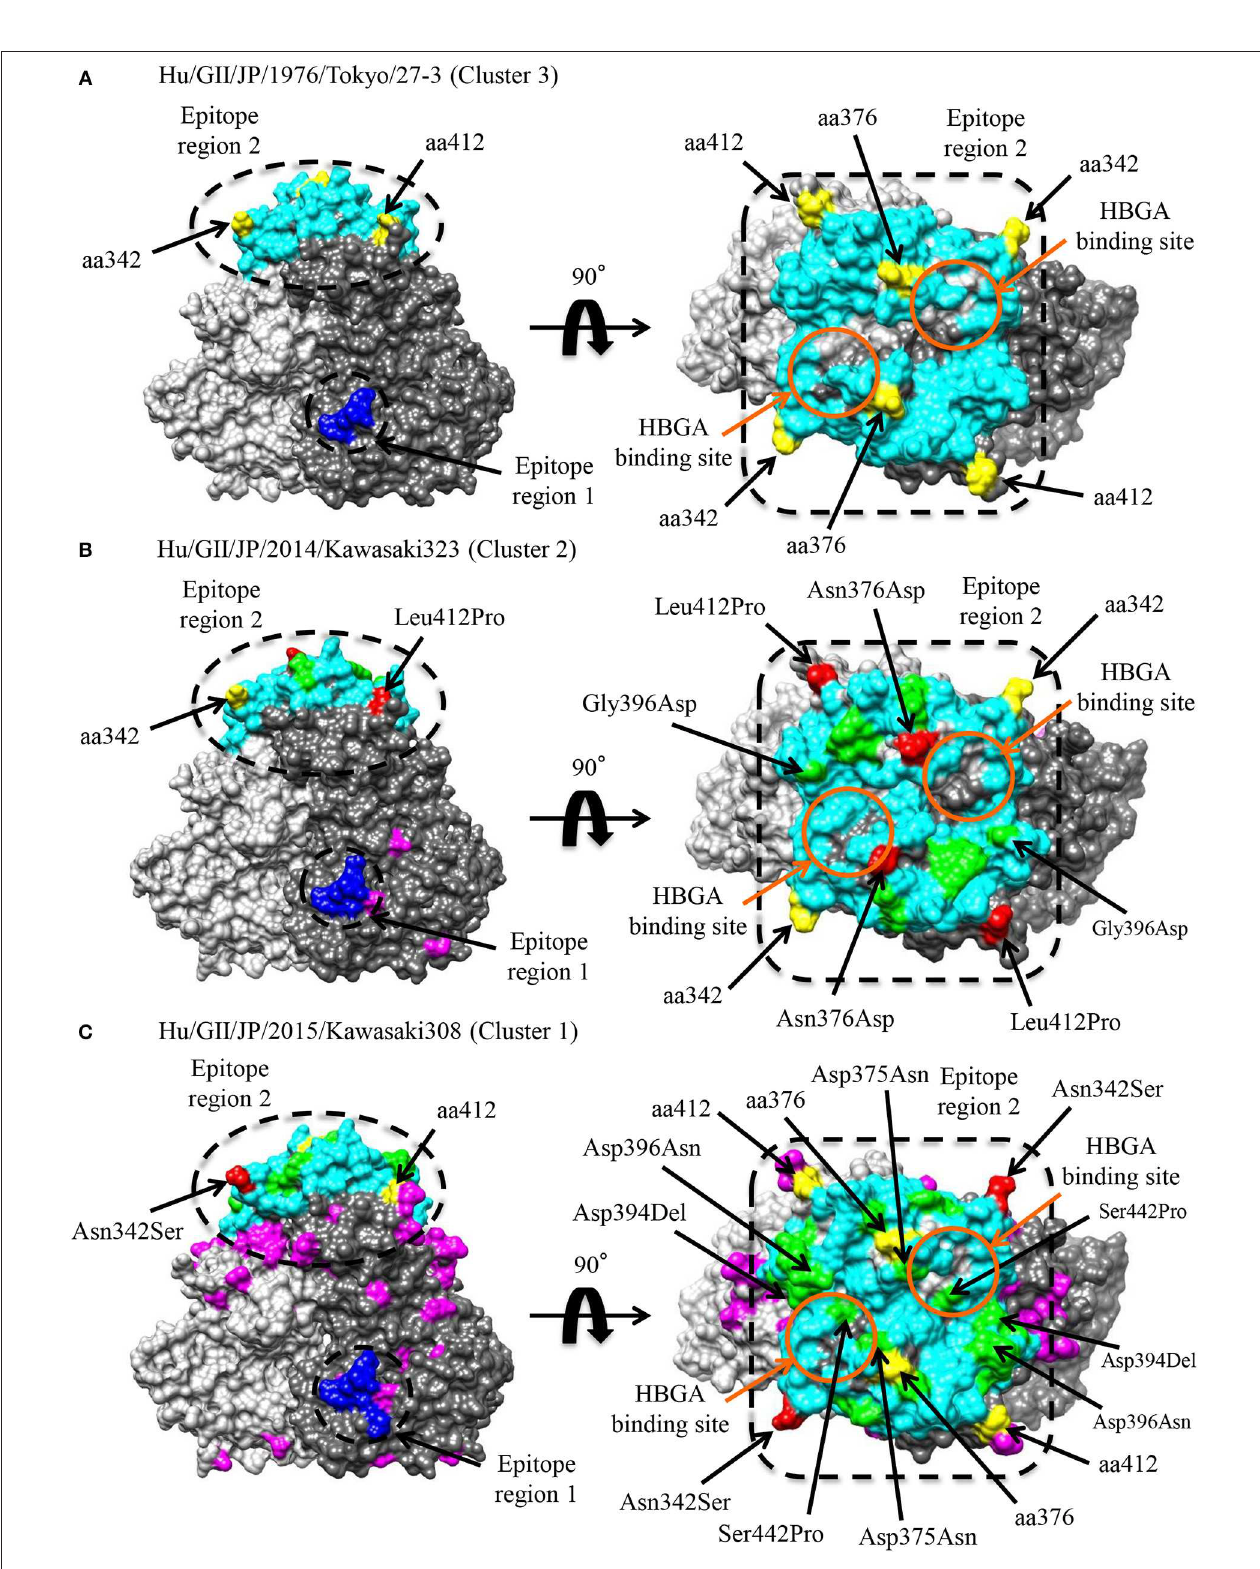
FIGURE 5 | Structural models of the VP1 protein for representative GII.17 strains in the clusters of the Kawasaki2014 variant and its ancestor. Three-dimensional VP1 dimer structures for Tokyo/27-3 [ancestor; cluster 3; (A) ], Kawasaki323 [cluster 2; (B) ], and Kawasaki308 [cluster 1; (C) ] viruses are shown. Each monomeric